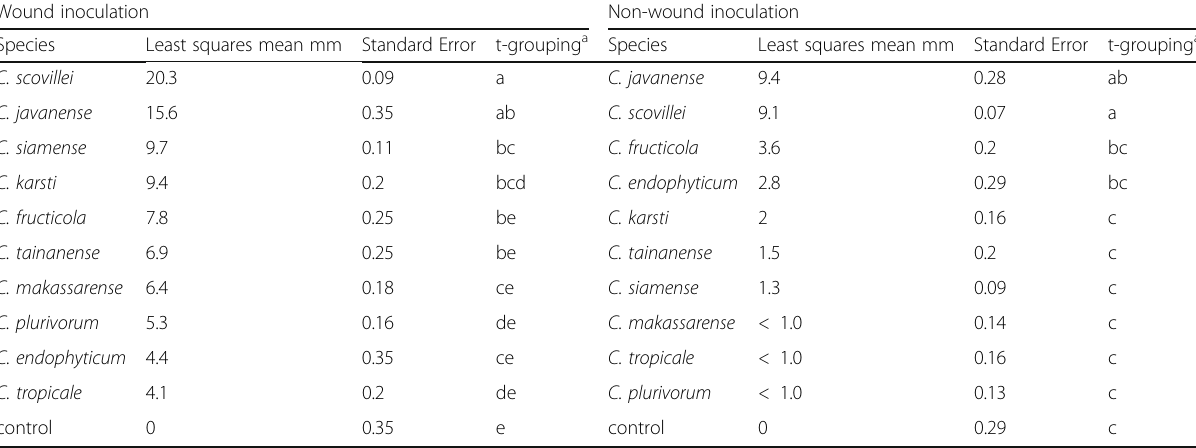
Table 5 Mean lesion size of symptoms caused by Colletotrichum species with straight conidia on inoculated mature red fruit of Capsicum annuum cv. Bangchang